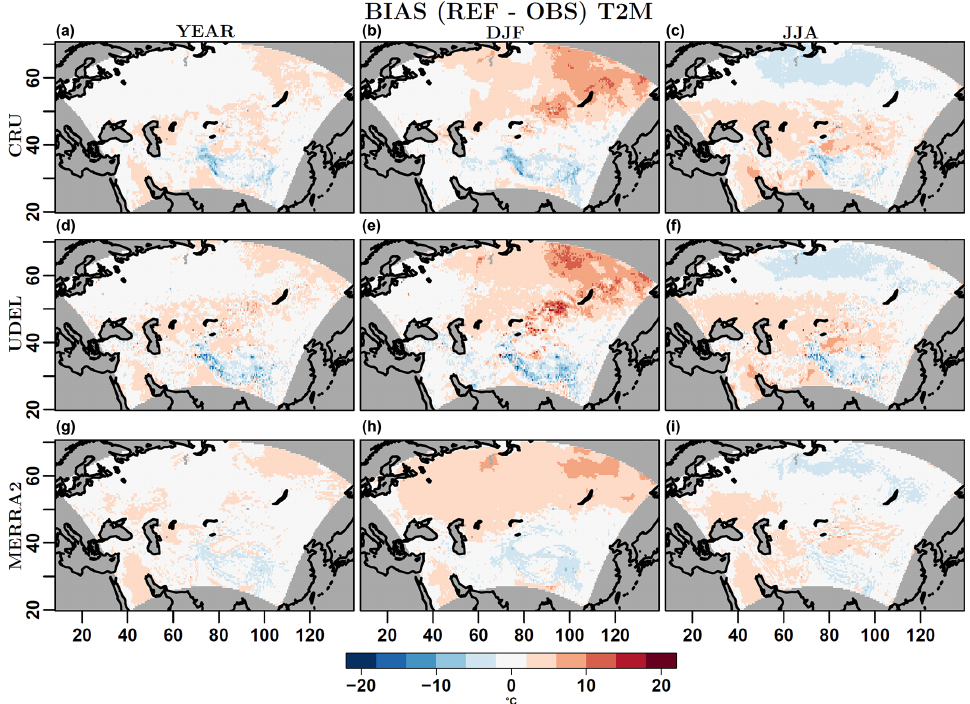
Figure 4. Mean bias of annual mean (a, d, g) , winter mean (b, e, h) and summer mean (c, f, i) near-surface temperature (T2M, ◦ C), of the reference COSMO-CLM simulation (a) with respect to three observational data sets (from top to bottom: CRU, UDEL and MERRA2), for the period